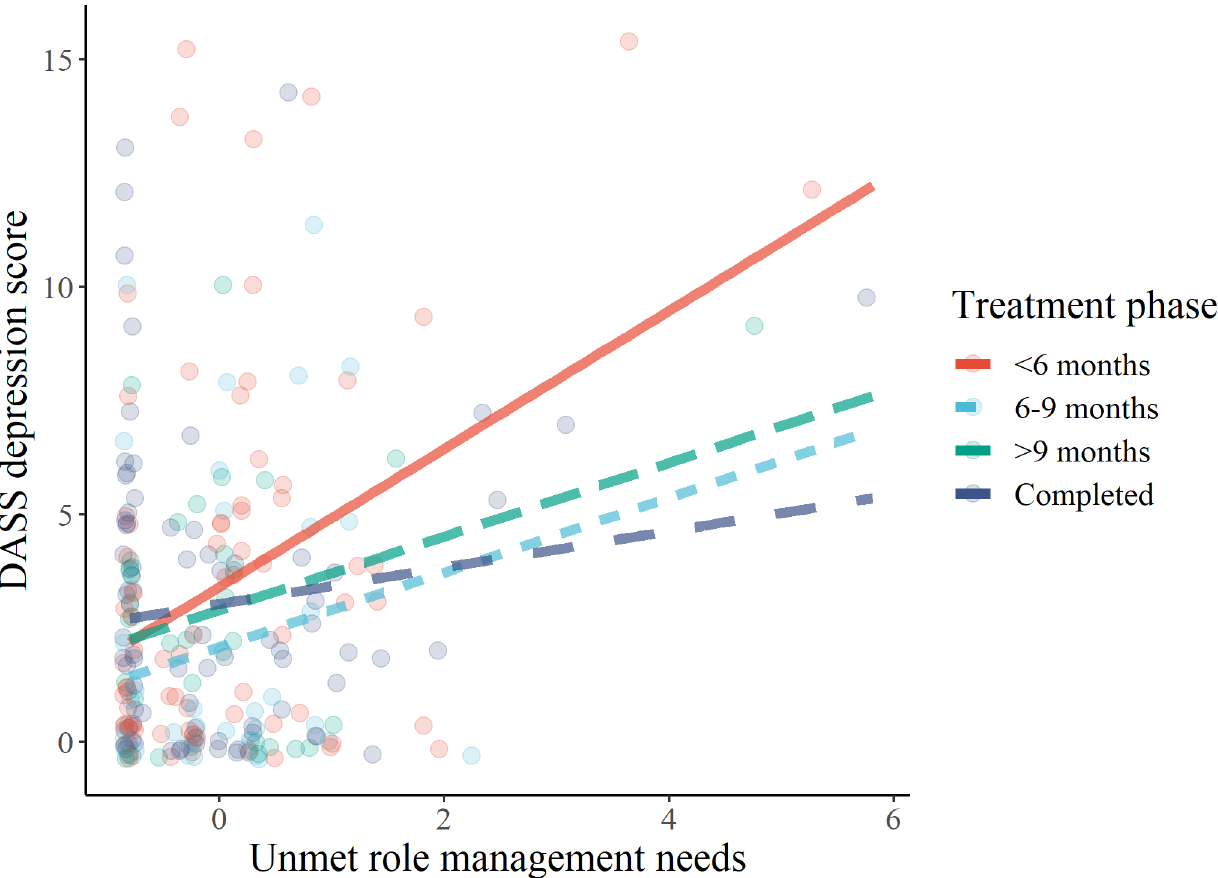
Fig 1. Relationship between unmet role management needs and DASS depression score across treatment phases. Greater unmet role management needs were associated with greater Depression, Anxiety, and Stress Scale (DASS) depression score in general. Moreover, compared with their loved ones undergoing treatment for less than six months, family caregivers with care recipient who have completed treatment had less positive relationship between unmet role management needs and DASS depression